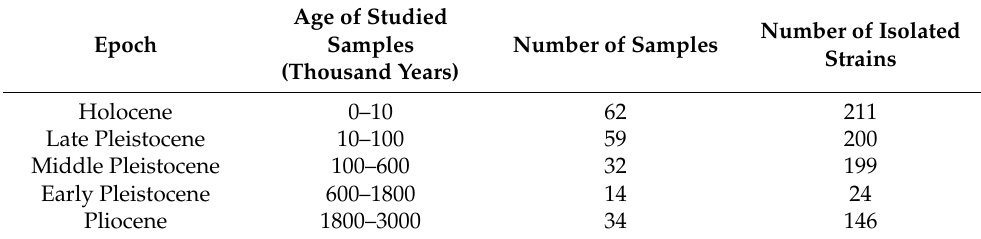
Table 1. Structure of collection of paleofungi by age of the studied samples.